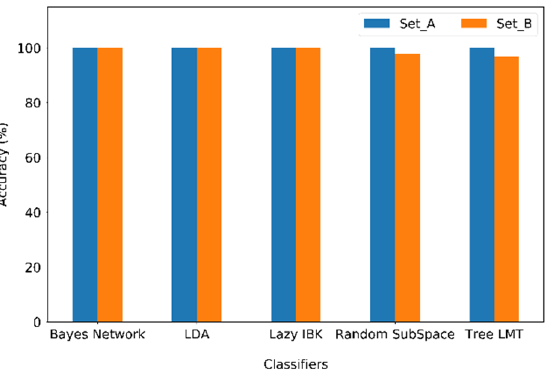
Figure 9. Comparison of the accuracies of the different classifiers used for set A and set B